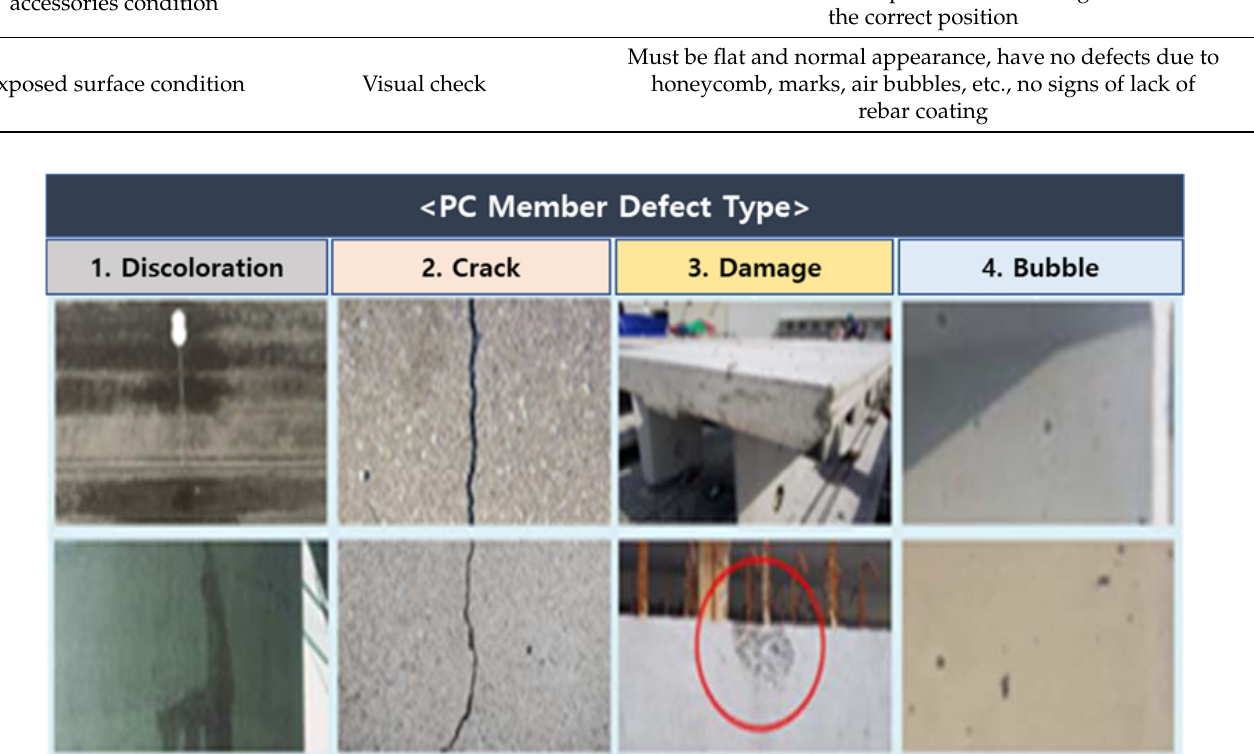
Figure 4. Major defect types of PC members.